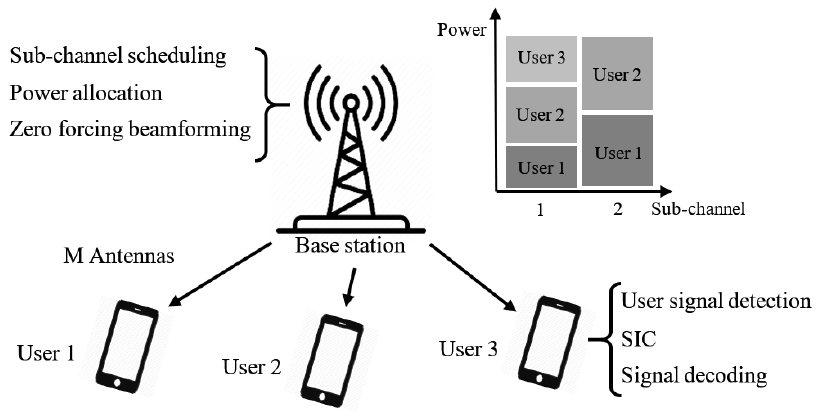
Figure 1. Illustration of downlink MC-NOMA